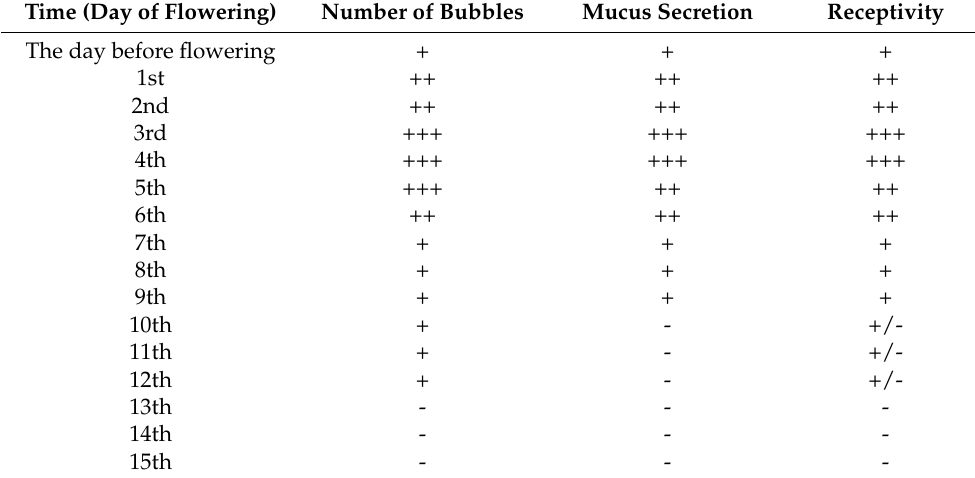
Table 3. Receptivity of R. pulchrum stigmas. Time (Day of Flowering) Number of Bubbles Mucus Secretion